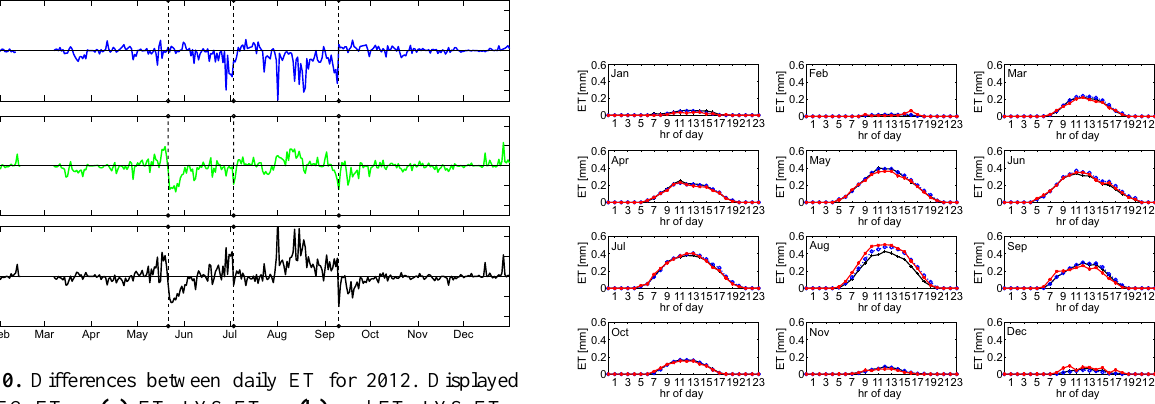
Figure 11. Relationship between grass length difference (between the lysimeters and the field behind the EC device) and ET a differ- ence measured by lysimeters and EC station from 21 May to 3 July.